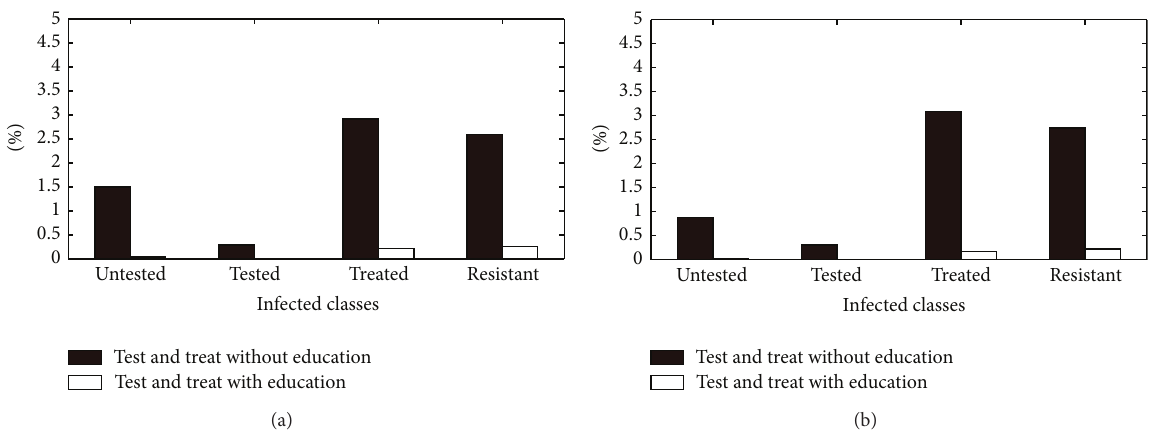
Figure 7: Comparison between percentage of infected (after 30 years, using model (2)) in different classes in the absence of education (solid boxes) and when the following education parameters are considered: 𝑝 = 0 . 75, 𝜌 𝑒 = 1, and 𝜌 𝑒𝑡 = 1 (white boxes). (a) Early treatment and average testing ( 𝜎 𝑡 = 𝜎 𝑒𝑡 = 4 and 𝜎 𝑘 = 0 . 55). (b) Early treatment and rapid testing ( 𝜎 𝑡 = 𝜎 𝑒𝑡 = 4 and 𝜎 𝑘 = 1). Thus education has a greater effect on drug resistance than rapid testing.